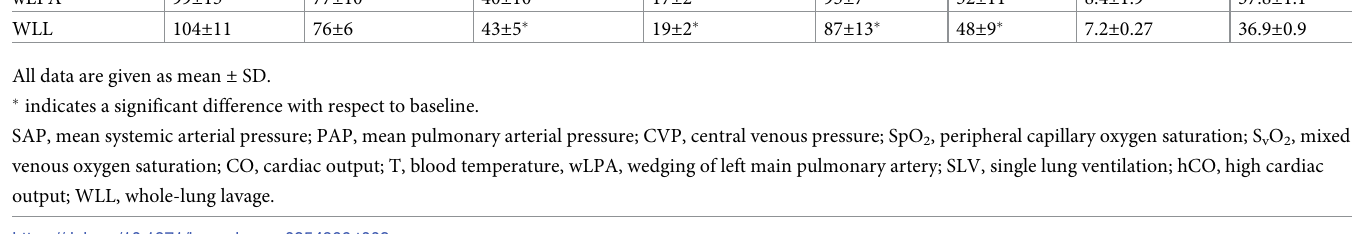
Respiratory enthalpy, dead space, venous admixture and P Respiratory enthalpy (reported as mean respiratory enthalpy difference) did not change signif- icantly during the four pathophysiological interventions. Dead space increased after wedging of the left main pulmonary artery ( P < 0 . 01 ) and lung lavage ( P < 0 . 01 ), venous admixture increased during single-lung ventilation ( P < 0 . 01 ) and repeated whole-lung lavage ( P < 0 . 01 ) and P O /F O decreased during all interventions ( P < 0 . 01 ). Large SDs in animals #1–6 were a 2 i 2 due to low respiratory enthalpy in animals #5 and #6. V/Q distributions and hemodynamic parameters were comparable to animals #1–4. During the PEEP trial, both venous admixture and dead space were reduced with increasing PEEP levels (statistically significant for 15 PEEP when compared to zero PEEP). In contrast, effects on respiratory enthalpy were not significant. Table 3 and Fig 3 show results for respira- tory enthalpy, dead space, venous admixture and P